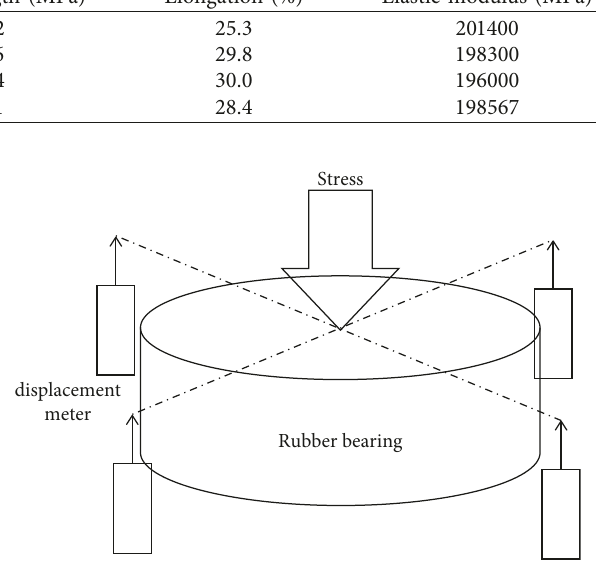
Figure 11: Schematic diagram of the relative position of the displacement meter and the bearing. Figure 10: Field test setup